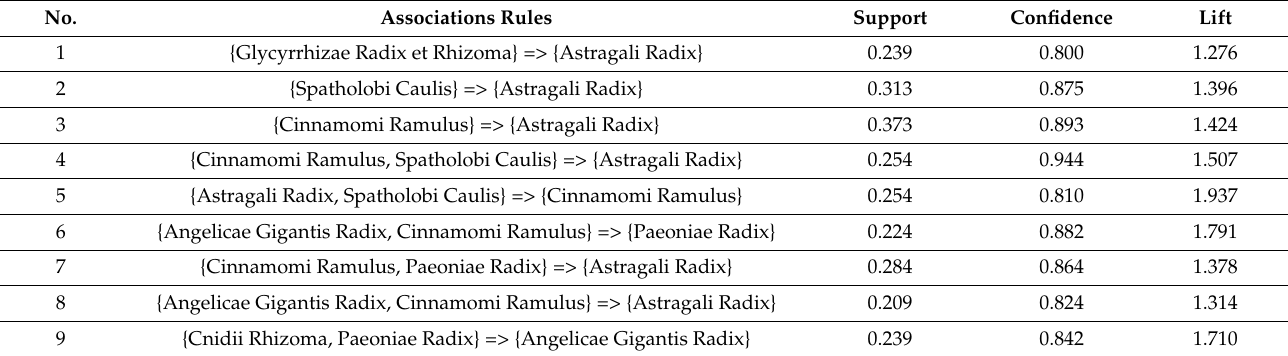
Table 5. Apriori algorithm-based association rules for EAHM prescribed for peripheral neuropathy.